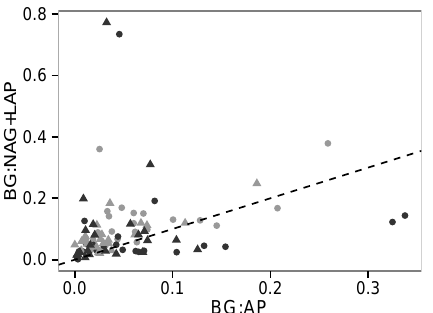
Figure 5. Scatterplot of microbial enzyme ratios (BG : NAG + LAP vs. BG : AP) about the 1 : 1 line. Included are C : P and C : N ac- quisition data of lake epilimnia (circles) and hypolimnia (triangles) from June (gray) to July (black). Dotted line indicates 1 : 1 (45 ◦ ) line. Vector angles (indicative of nutrient limitation) are calculated from these plotted data points, as deviation from the 1 : 1 line.